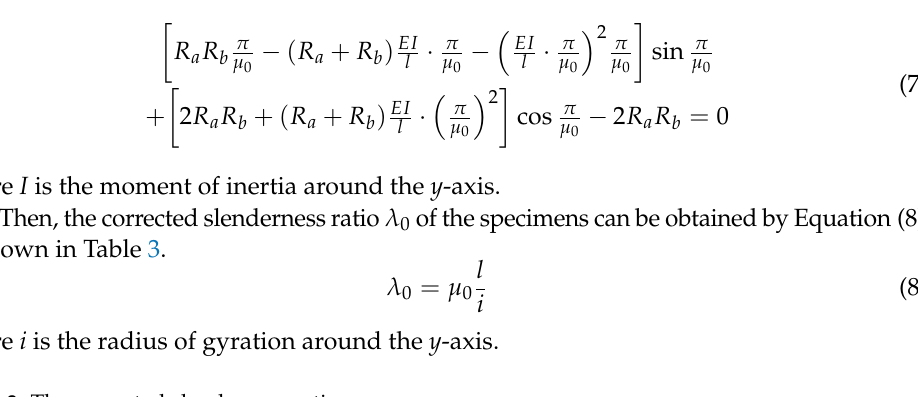
Table 3. The corrected slenderness ratio. Tension Coupon